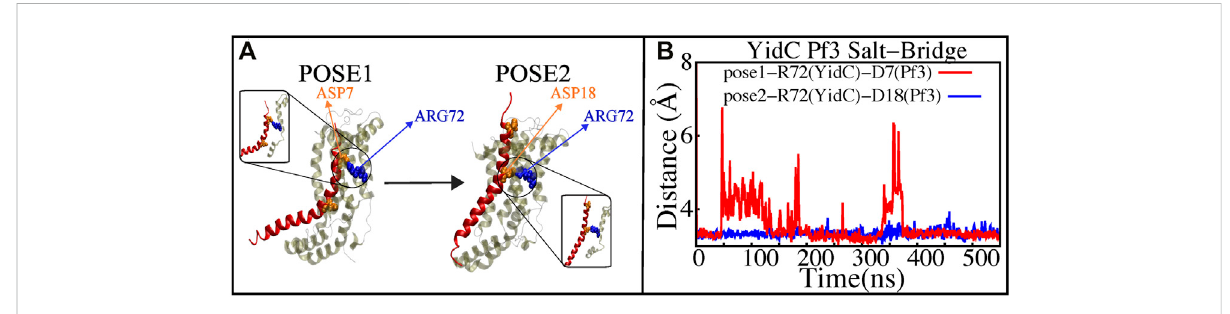
FIGURE 7 Salt — bridge connectivity of R72 (YidC) located in the groove. (A) Graphical representation of signi fi cant salt-bridge interactions between the Pf3 coat protein and YidC involved in the insertion process. (B) Distance between salt-bridge Arg72 (YidC) — Asp18 (Pf3 coat protein) and Arg72 (YidC) — Asp7(Pf3 coat protein) (labeled with blue and red lines, respectively) in YidC and Pf3 coat protein docking models.